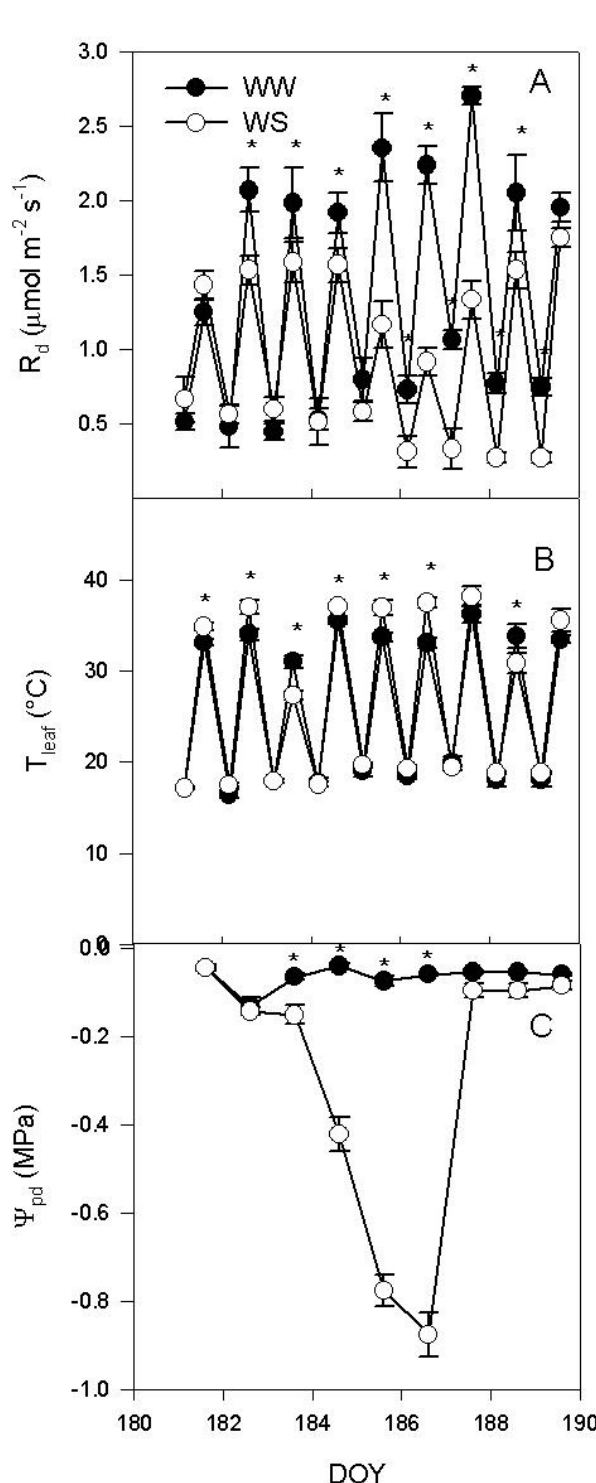
Figure 2. ( A ) Dark respiration (R d ), ( B ) leaf temperature (T leaf ) at 4:00 a.m. and midday, and ( C ) pre- dawn water potential ( Ψ pd ) recorded on mature leaves of well-watered (WW) and water stressed vines (WS) during the experiment. Each point is the mean of six vines ± SE. Points marked by asterisk are different per p < 0.05 ( t -test).